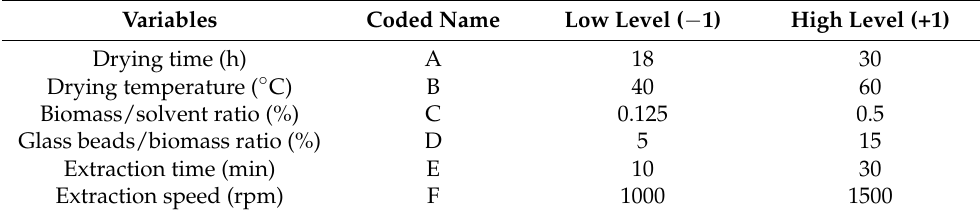
Table 1. Variables evaluated with their levels for the extraction of